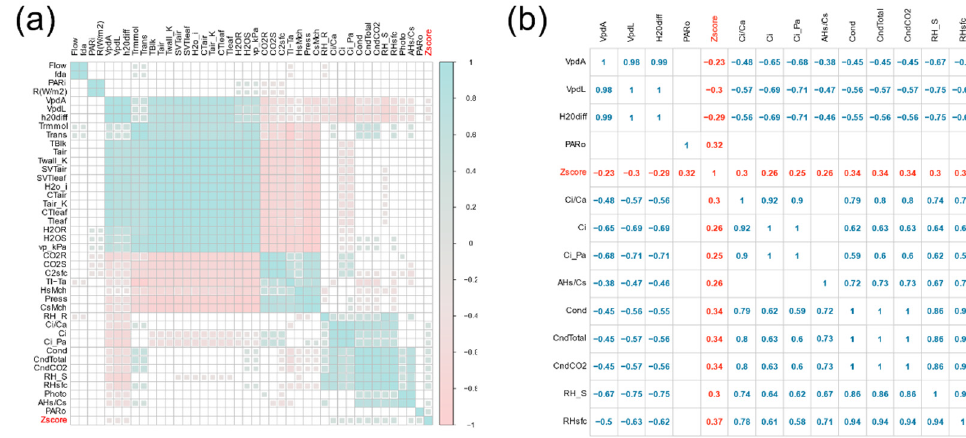
Figure 3. Heat map of Pearson correlation coefficient. ( a ) Forty-one characteristics; ( b ) 13 characteristics. Table 3. The specific meanings and correlation coefficients of 13 features.